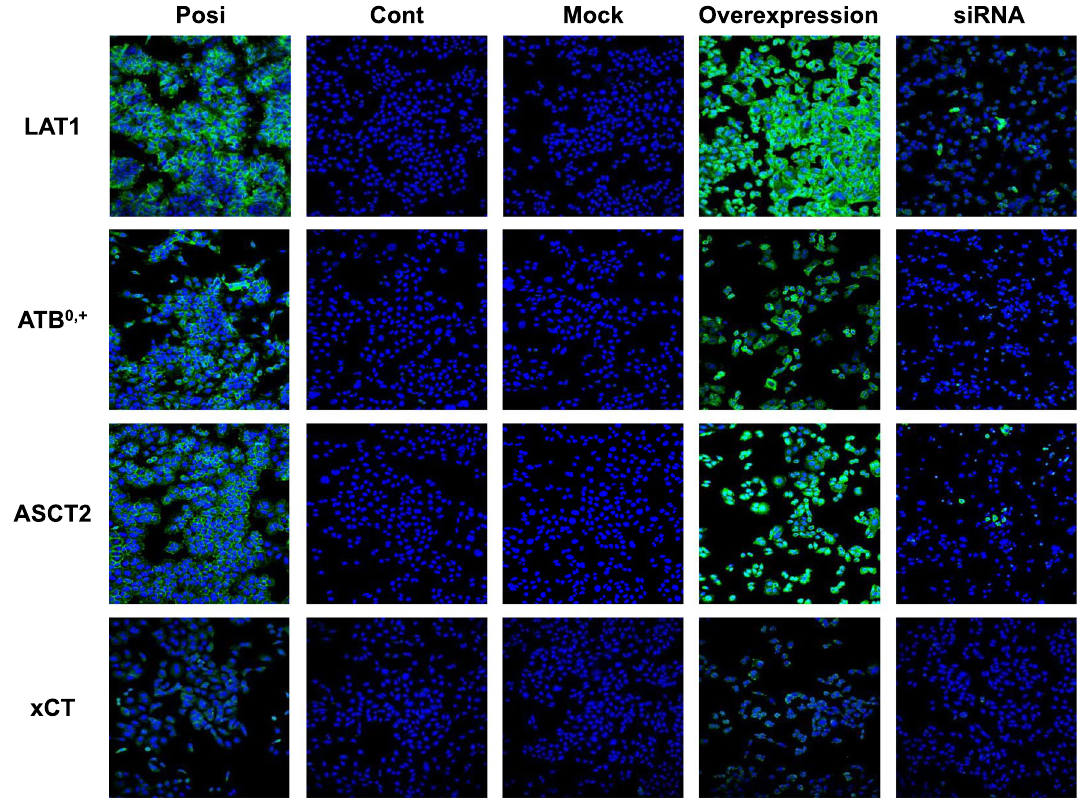
Fig. 3 Immunofluorescent analysis of human amino acid transporters. Immunofluorescent analyses were performed using anti-human A LAT1, B ATB 0, + , C ASCT2, and D xCT antibodies (green) on the positive-control cells, negative-control cells (CHO-K1 cells), control vector-transfected cells (Mock), expression vector-transfected cells, and gene-specific siRNA-transfected cells. The positive-control cells were A MCF-7, B T3M-4, C NCI-H460, and D A549 cells. Nuclei were visualized by 4’,6-diamidino-2-phenylindole (DAPI) staining (blue)